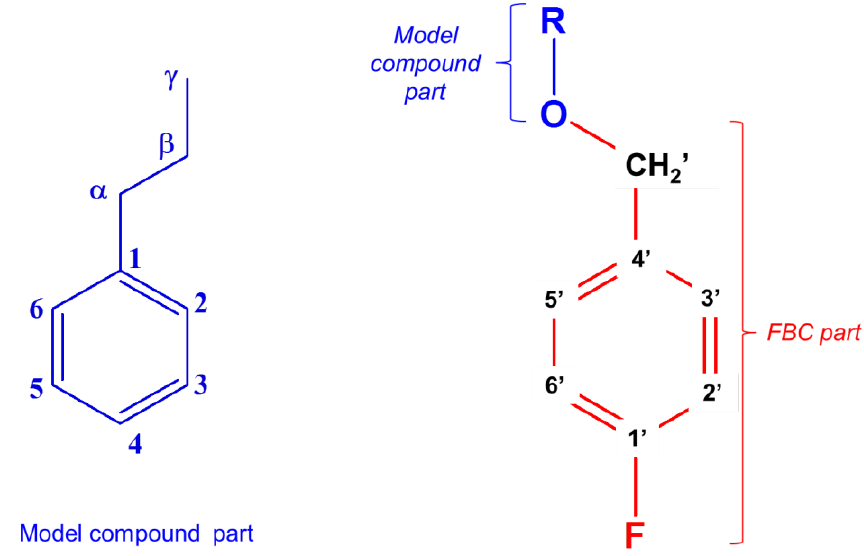
Figure 4. Structure and number assignment of fluorobenzylated model compounds and lignin.